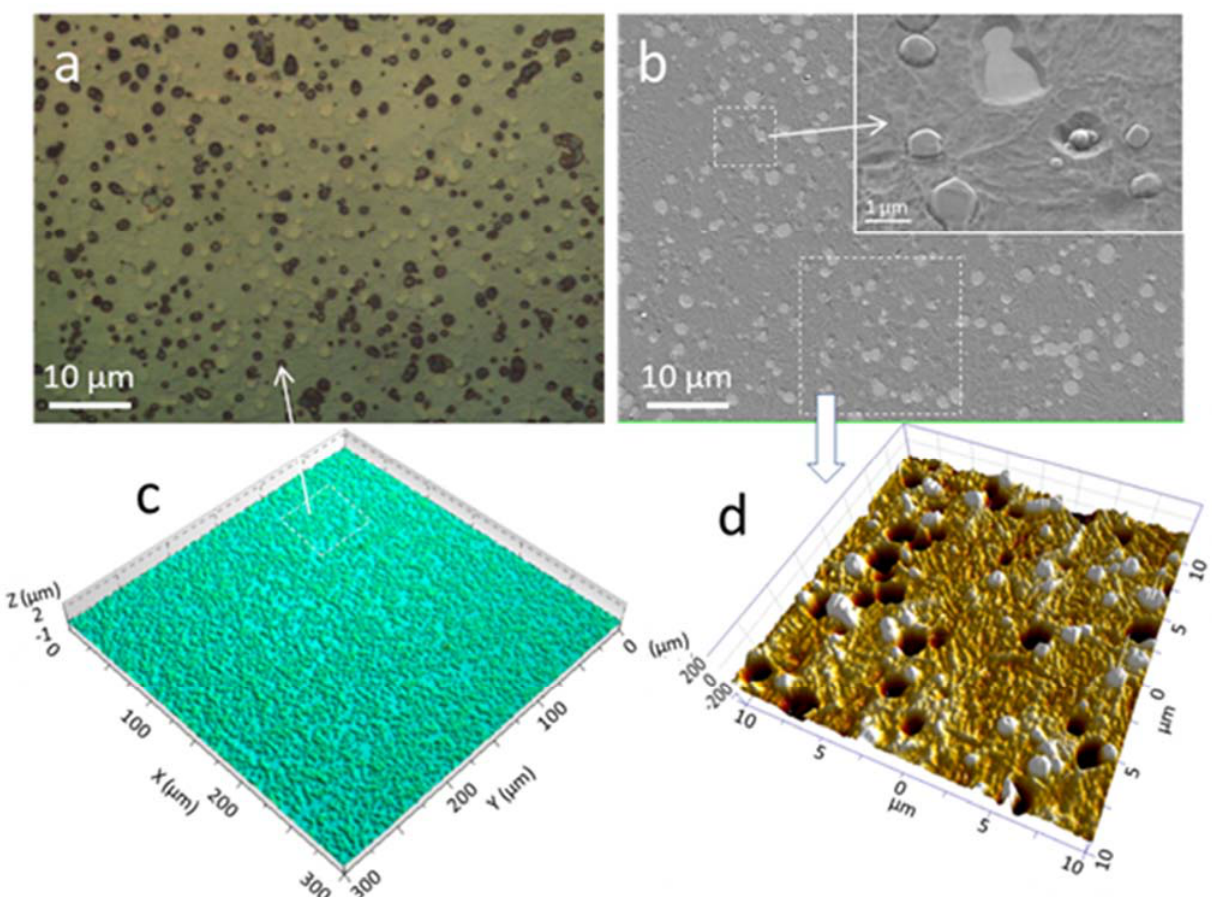
Figure 8. OM image ( a ); SEM images at lower ( b ) and higher magnification (see inset); 3D profile image ( c ); AFM image ( d ) of the ASP tool steel substrate surface after DC ion etching in BAI deposition